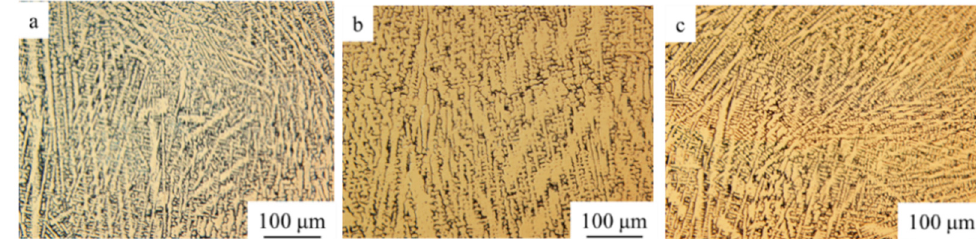
Figure 4. Microstructure of different compositional NiCrAlY-ZrO 2 samples: ( a ) 10% ZrO 2 , ( b ) 20% ZrO 2 , ( c ) 30% ZrO 2.